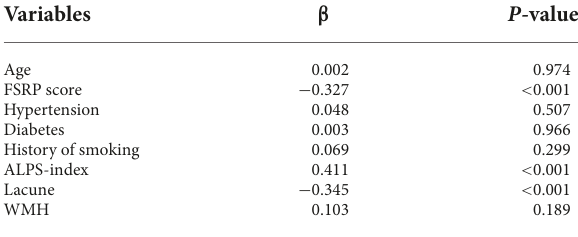
TABLE 3 Multivariate analyses of MoCA. Variables